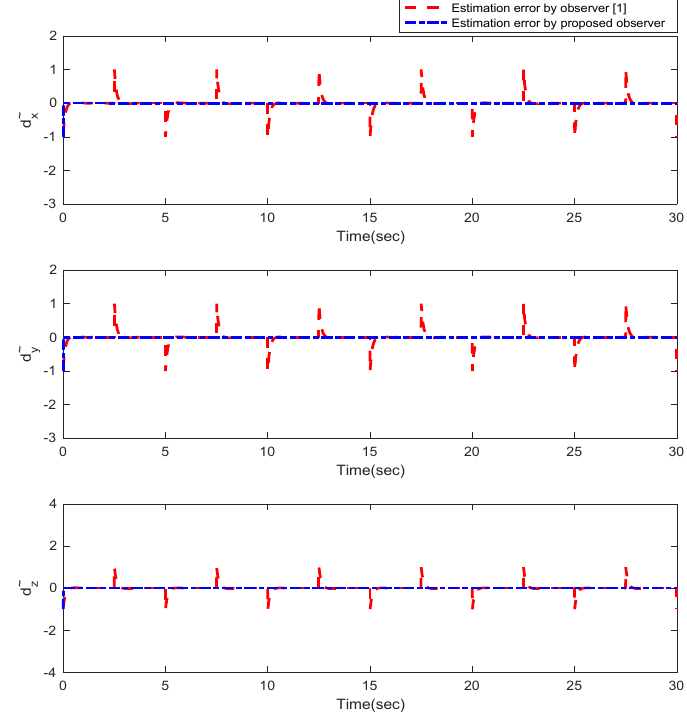
Figure 12. Estimation error of the observer for position of quadrotor.